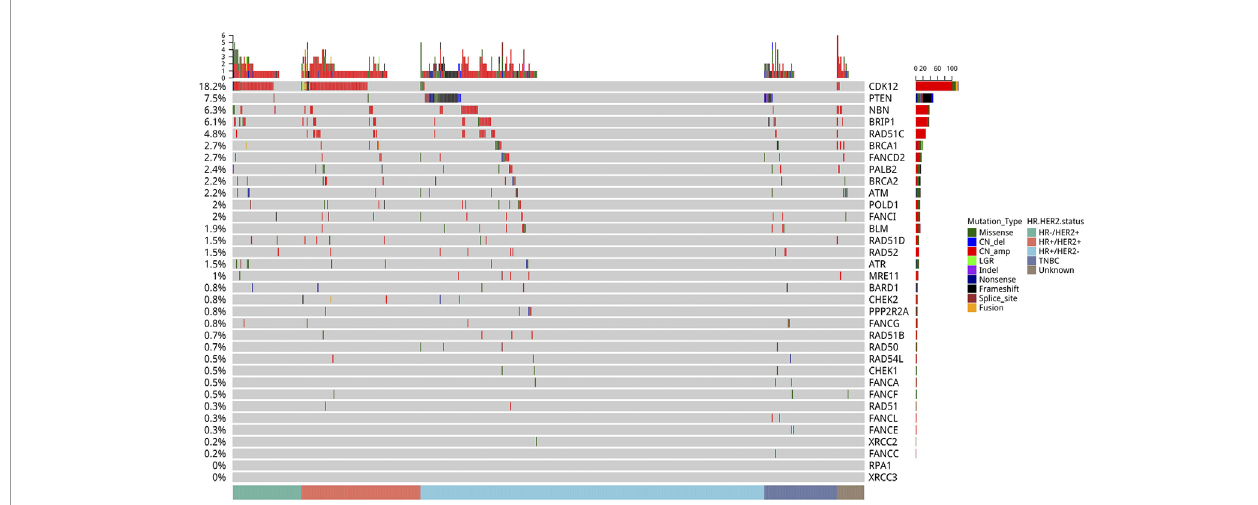
FIGURE 4 | Mutation pro fi le of genes in the homologous recombination repair (HRR) pathway. Tumor samples were grouped by molecular subtype: HR+/HER2 − (n = 321), HR+/HER2+ (n = 111), HER2-enriched (n = 64), and triple-negative breast cancer (TNBC) (n = 68) as indicated by the annotation at the bottom. The mutation frequency for each gene is shown on the left. Colors indicate the mutation